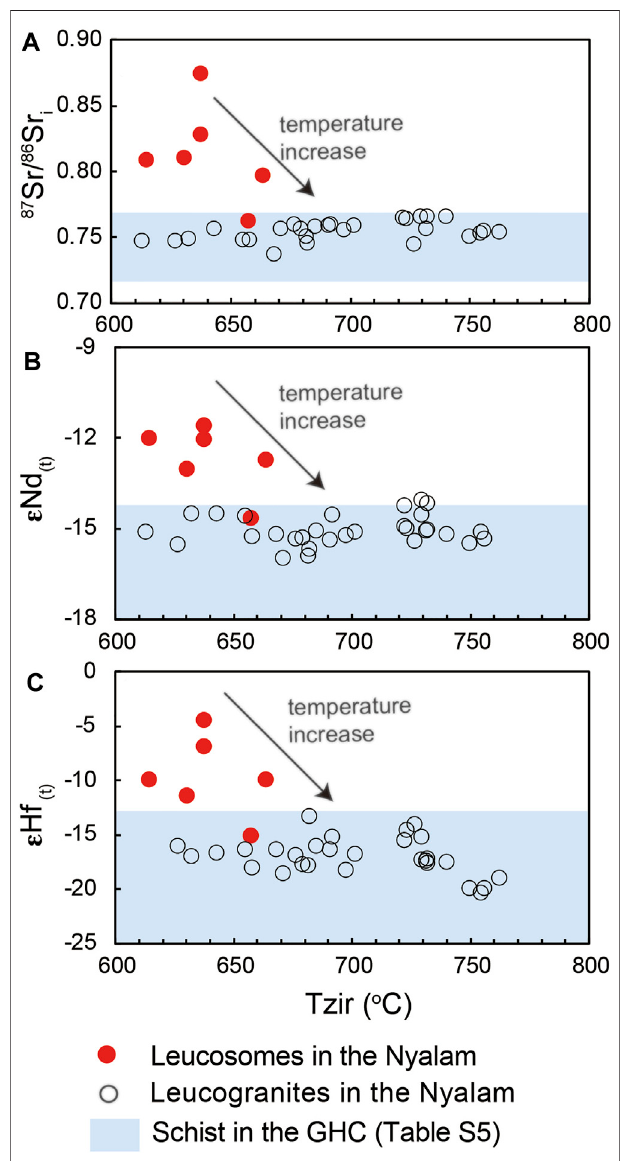
FIGURE 7 | The diagrams show the change of (A) 87 Sr/ 86 Sri, (B) ε Nd (t) , (C) ε Hf (t) of leucosome and leucogranite with the crystallization temperature. The crystallization temperature was estimated by zircon saturation thermometer (Watson and Harrison, 1983. The blue areas represent the isotope range of the GHC.